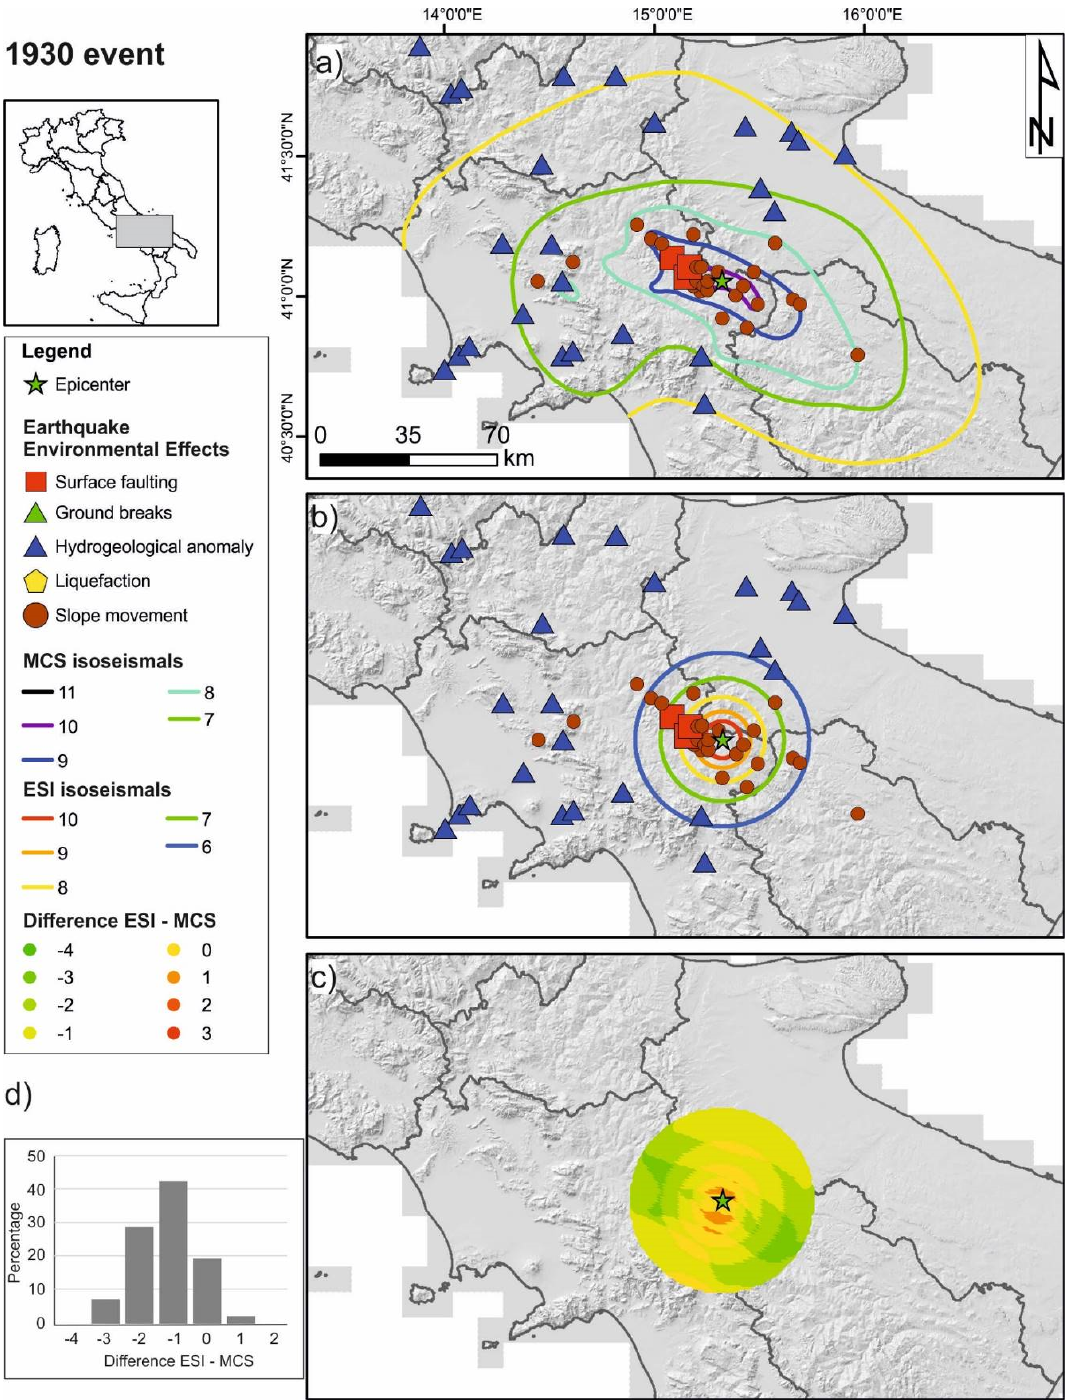
Figure 7. ( a ) map of EEEs and MCS isoseismals of the 1930 earthquake; ( b ) map of EEEs and ESI isoseismals derived from the intensity prediction equation (IPE); ( c ) map showing the difference between ESI and MCS intensities; ( d ) histogram of the ESI-MCS difference. Inset shows, in the grey rectangle, the study area in a larger map around Italy.